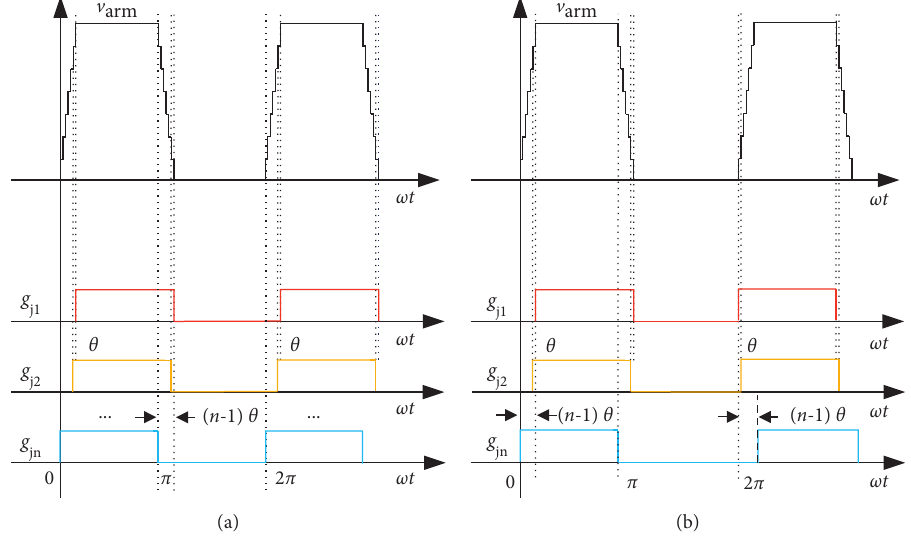
Figure 3: Modulation strategy. (a) NPS and (b)